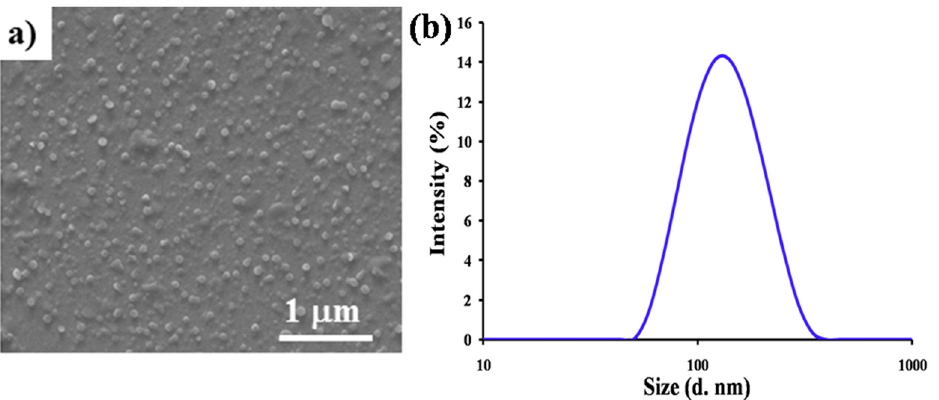
Figure 9. ( a ) Field emission scanning electron micrographs (FE-SEM) of the spherical aggregate of 1 (10 − 5 M) upon solvent evaporation on a silicon wafer; ( b ) Average hydrodynamic diameter of 80% water/acetonitrile aggregates and the size measured using a dynamic light scattering (DLS) particle size analyzer.